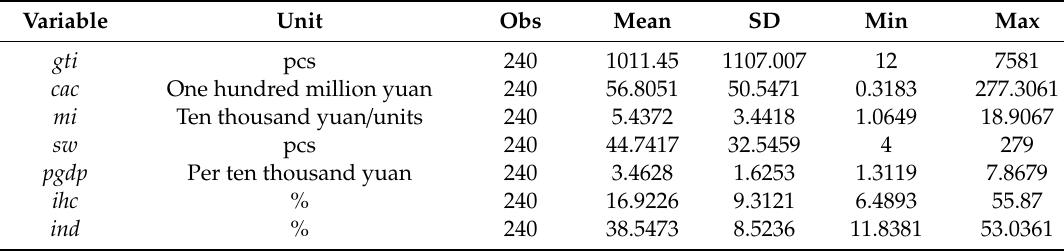
Table 2. Descriptive Statistical Results of